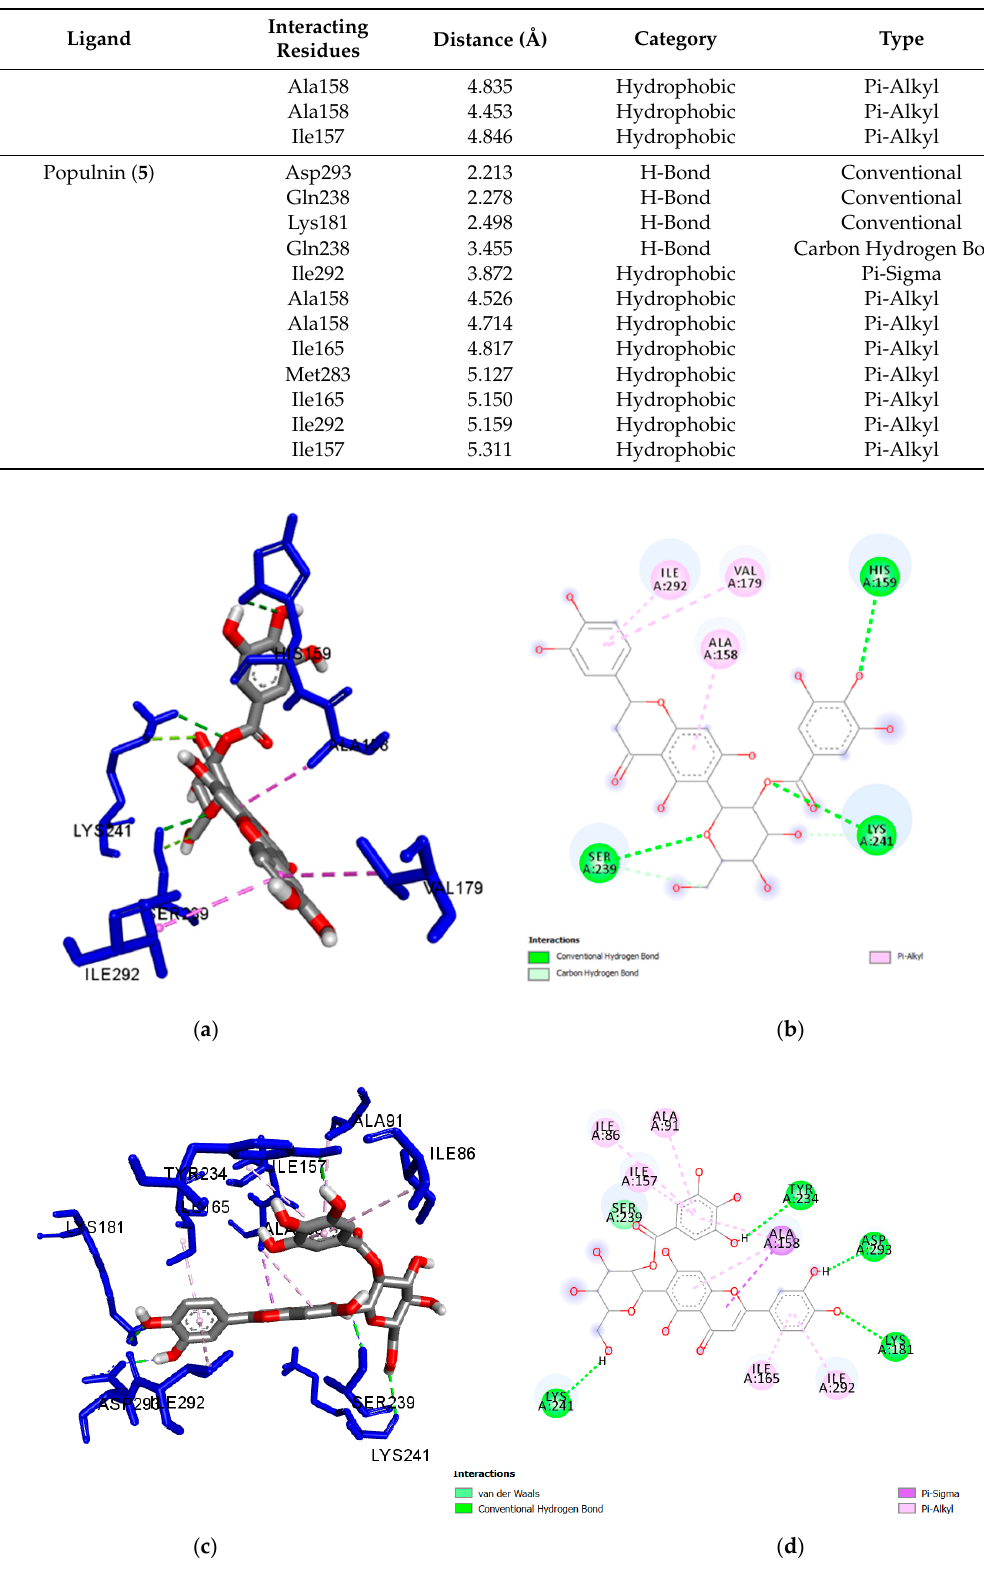
Figure 2. ( a ) Docked pose of rigid isoorientin 2”- O -gallate ( 1 ) in the Mt PknG binding site, showing molecular interactions—hydrogen and hydrophobic bonds as green and pink/purple dashed lines, respectively; ( b ) 2D plot of interactions between ( 1 ) and key residues of Mt PknG generated by BIOVIA Discovery Studio visualizer. The solvent accessible surface is depicted as a background grey circle with the radius proportional to the exposure. ( c ) Docked pose of flexible isoorientin 2”- O -gallate ( 1 ) in the Mt PknG binding site showing molecular interactions—hydrogen and hydrophobic bonds as green and pink/purple dashed lines, respectively; ( d ) 2D plot of interactions between ( 1 ) and key residues of Mt PknG generated by BIOVIA Discovery Studio visualizer. The solvent accessible surface is depicted as a background grey circle with the radius proportional to the exposure.